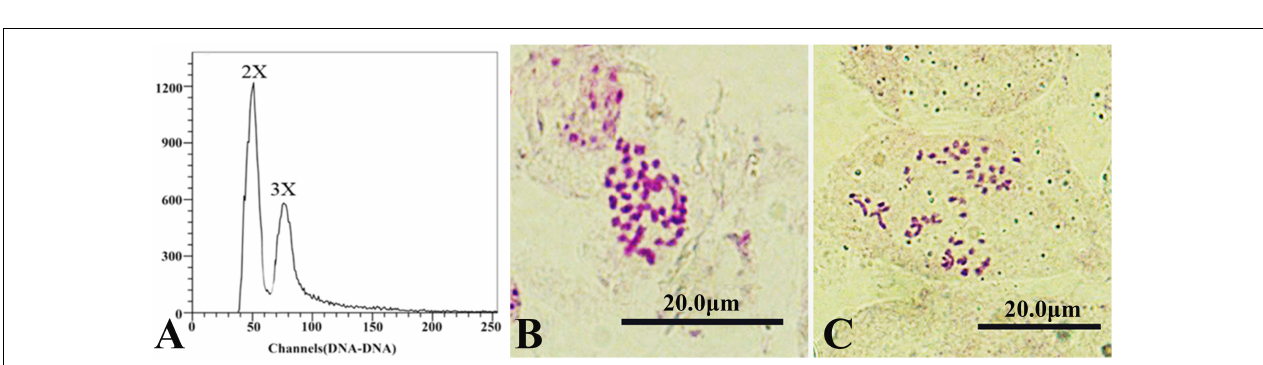
FIGURE 2 | Scanning electron micrographs of P. canescens pollen grains derived from untreated and treated male flower buds with 0.5% colchicine at pachytene. (A) Morphology of the pollen grains in the control group and natural 2n pollen grains. (B) Morphology of the pollen grains derived from the treatment given 5 injections at pachytene and induced 2n pollen grains. (C) Morphology of the pollen grains derived from the treatment given 11 injections at pachytene and induced 2n pollen grains. (D–F) Ectexine deposition; (D) haploid pollen grains in the control group; (E) haploid pollen grains derived from the 5 injections treatment at pachytene; (F) haploid pollen grains derived from the 11 injections treatment given at pachytene. (G–L) Details of the ectexine structure; (G) haploid pollen grains in the control group; (H) haploid pollen grains derived from the treatment given 5 injections at pachytene; (I) haploid pollen grains derived from the treatment given 11 injections at pachytene; (J) natural 2n pollen grains; (K) 2n pollen grains derived from the treatment given 5 injections at pachytene; (L) 2n pollen grains derived from the treatment given 11 injections at pachytene. Scale bar = 100 µ m (A–C) , 10 µ m (D–F) , 5 µ m (G–L) .